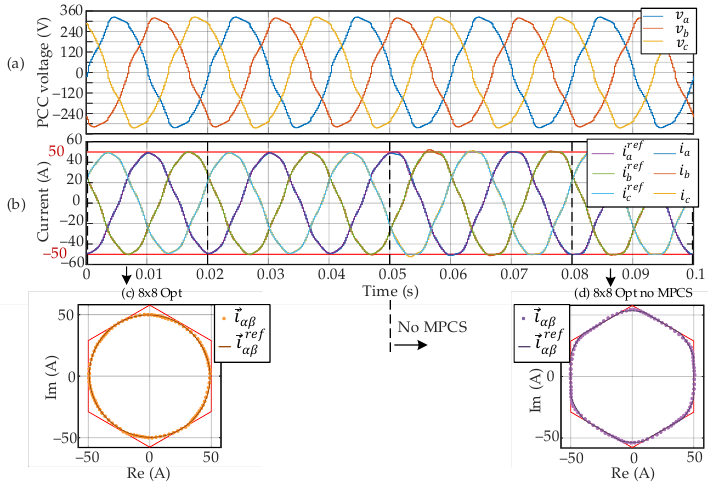
Figure 7. Analysis of MPCS operation: ( a ) PCC voltage; ( b ) PCC current; and trajectory in the complex plane of the current (cid:126) i αβ and its reference (cid:126) i ref with ( c ) MPCS and ( d ) no MPCS. αβ